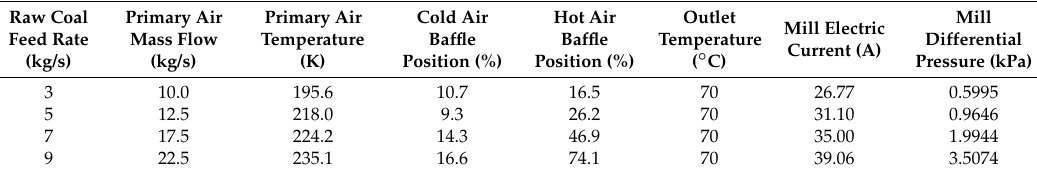
Table 4. Selected operating points.